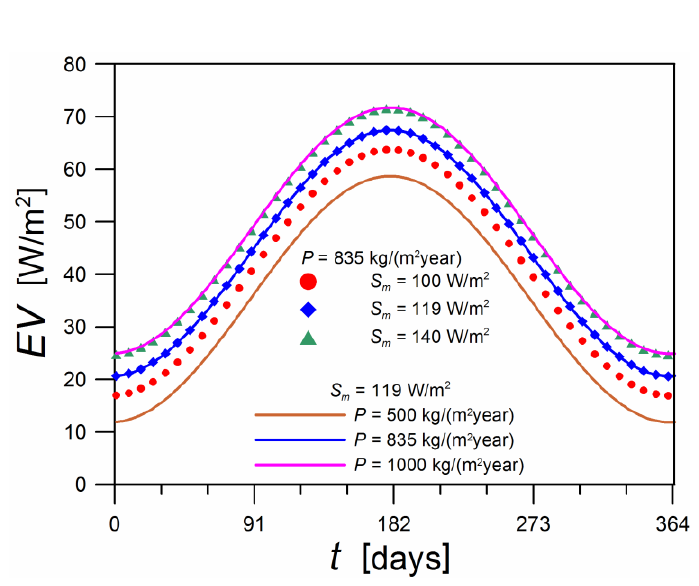
Figure 3. Time dependence of the evaporative flux EV for different values of the average solar radiation flux S m and the annual amount of precipitation P.